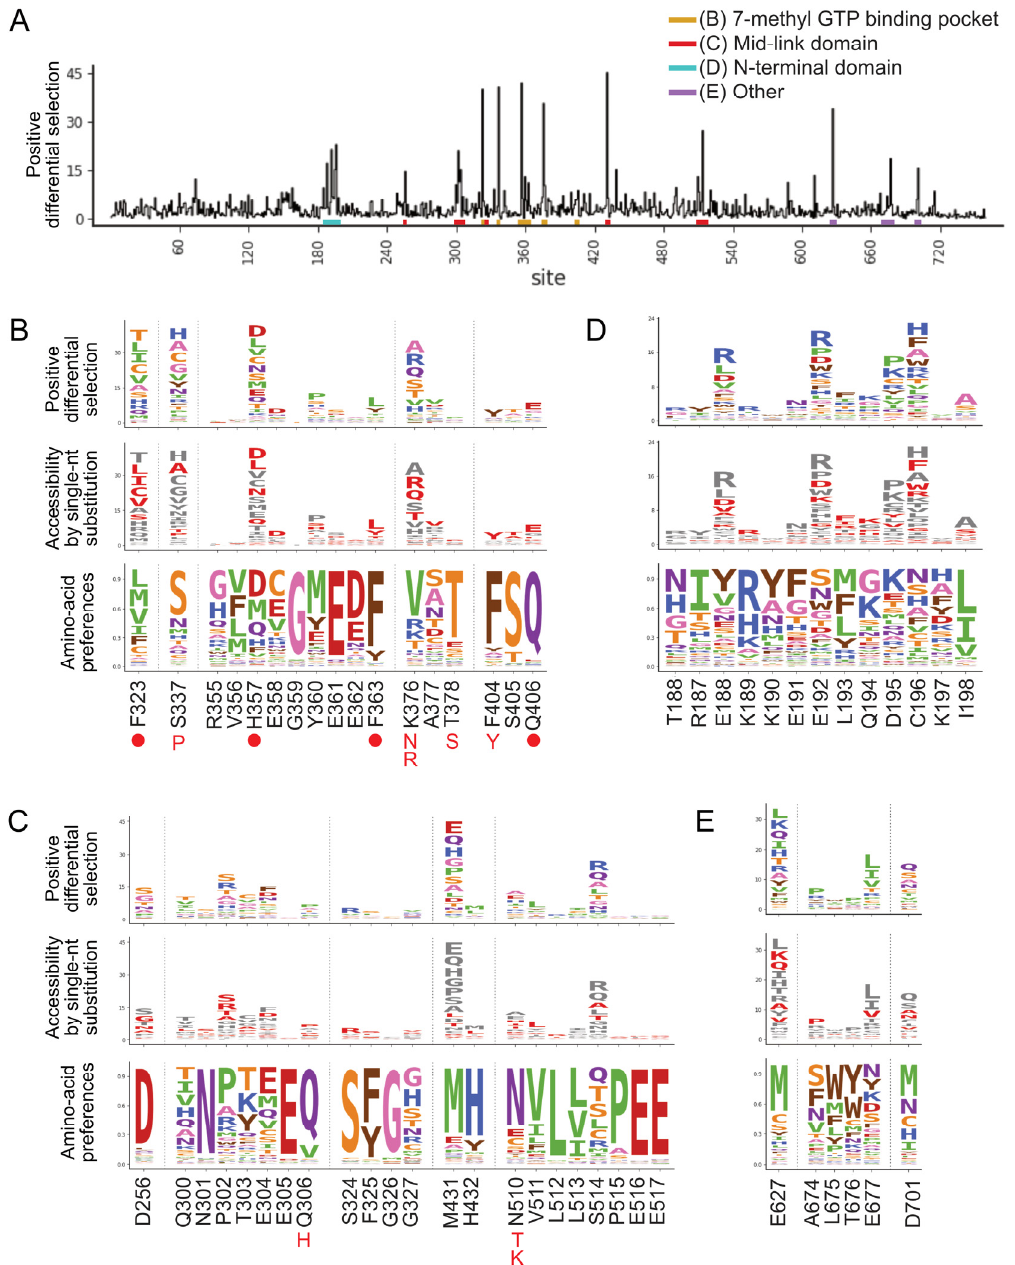
Figure 1. A complete map of pimodivir resistance. ( A ) Positive site differential selection across the entire PB2 protein. Regions of interest from different domains are underlined in different colors. ( B – E ) Mutation-level profiles for regions of interest in the ( B ) 7-methyl GTP binding pocket, ( C ) mid-link domain, ( D ) N-terminal domain, ( E ) other regions of PB2. The top plot of each panel shows the positive differential selection profile, where the height of each amino acid is proportional to its differential selection. The middle plot shows which amino acids are accessible by single-nucleotide substitution from existing avian PB2 sequences. Accessible amino acids are shown in red. The bottom plot shows the amino acid preferences at each site in human A549 cells, as previously measured in [26]. The preference for an amino acid is proportional to its enrichment during the prior functional selection of the complete PB2 mutant library in A549 cells. The height of each letter is proportional to the preference for that amino acid at that site. Sites of known resistance mutations are indicated by either a circle underneath the site or the specific resistance mutation if it is